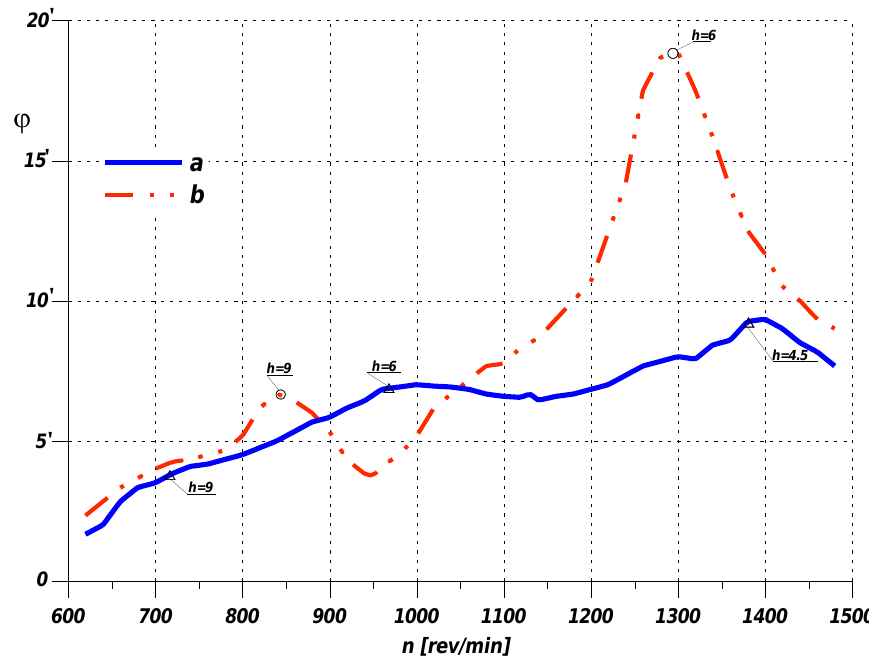
Figure 4. Torsional vibrations of the shaft—damper effectiveness: a—with a damper, b—without a damper [7,8]; h —number of harmonic order of vibrations.